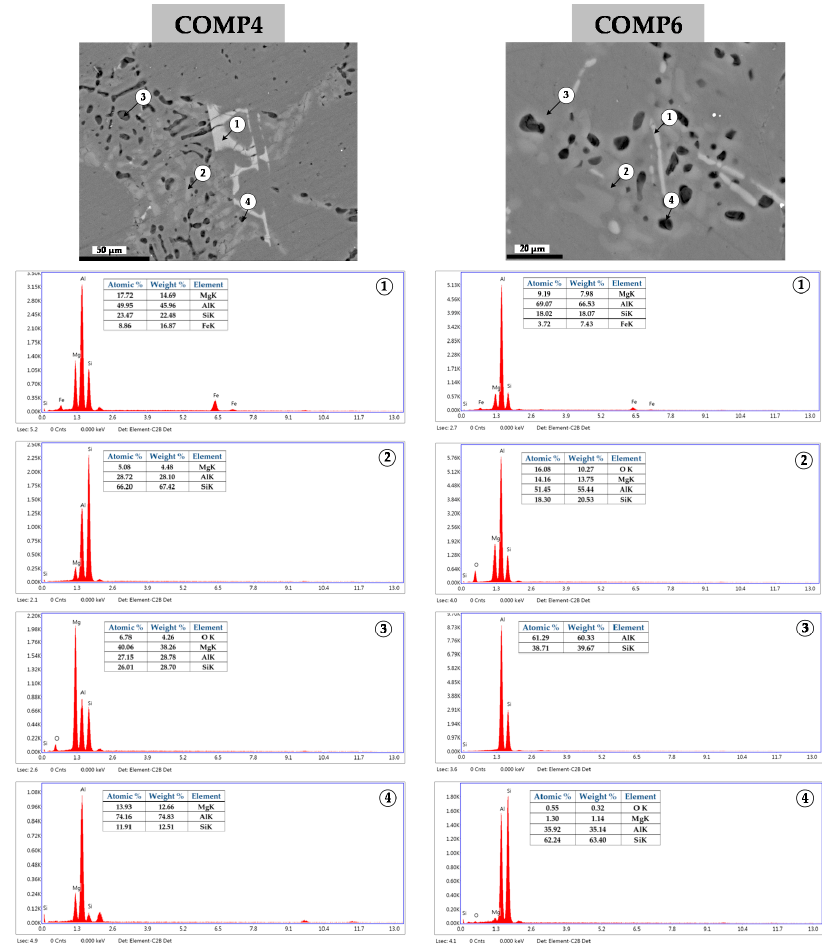
Figure 6. the EDS results of the samples with different values of additives. Figure 6. The EDS results of the samples with different values of